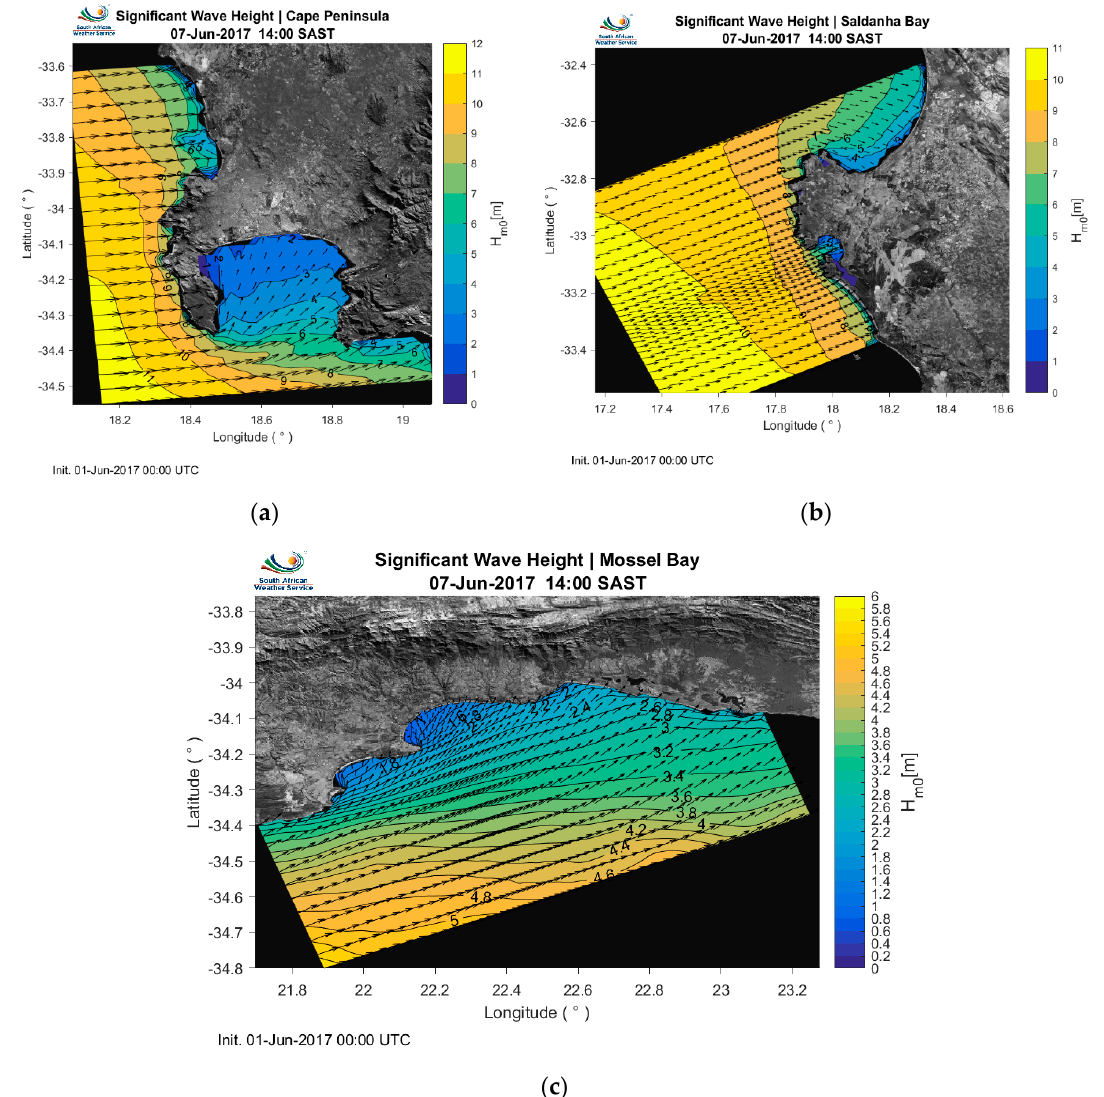
Figure 2. Example output from the SWaSS operational systems. Each of these is an example of the nearshore, high resolution, nested domains. Local refinements are also applied in the immediate vicinity of each buoy location. ( a ) Cape Town (CT) nested domain, ( b ) Saldanha Bay (SB) nested domain, and ( c ) the Mossel Bay (MB) nested domain.